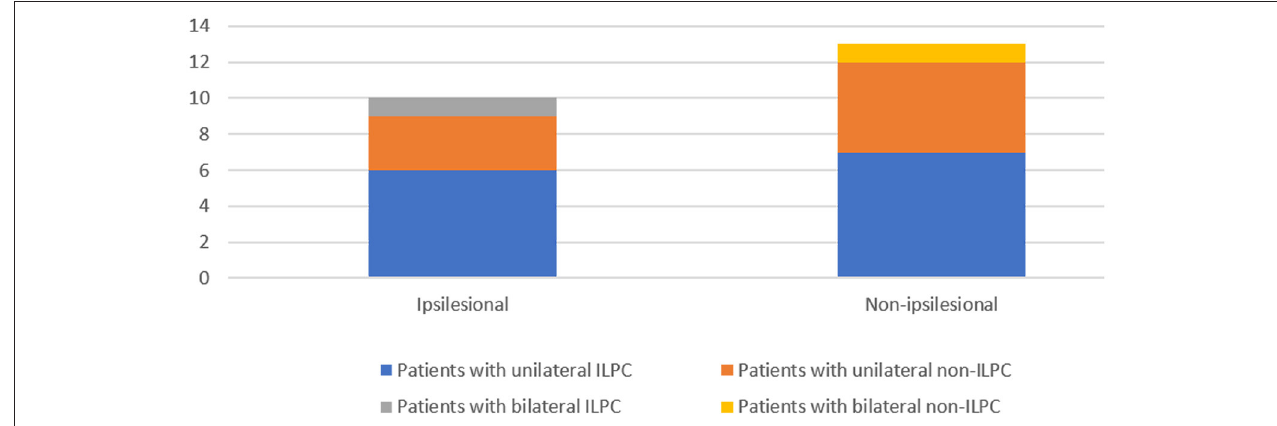
FIGURE 3 | Impairment of any of the four: Calorics, oVEMP, cVEMP, and PTA in patients with the loss of the posterior canal (s) (LPC).